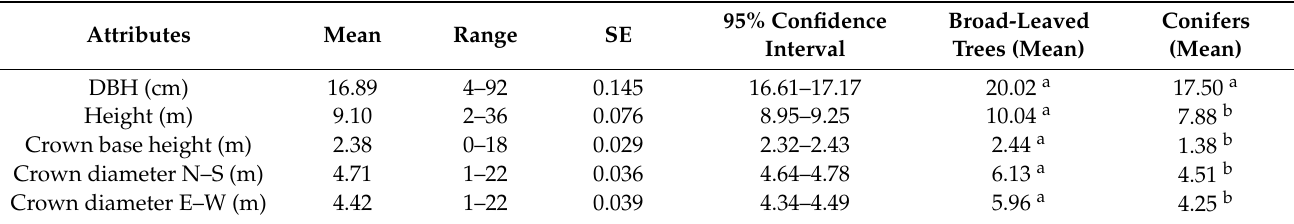
Table 1. Main characteristics of trees in the sample plots.